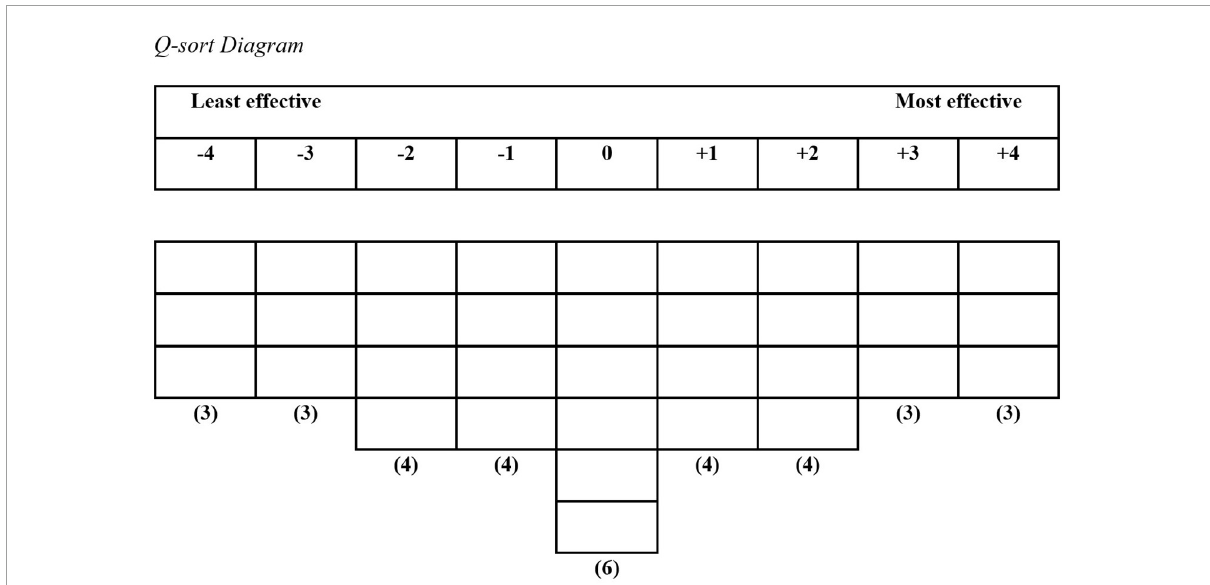
FIGURE1 Q-sort diagram. Participants sorted statement (coaches’ behaviors) into the grid from (–4) for the least effective behaviors, (0) for the neutral behaviors, to (+4) for the most effective behaviors.